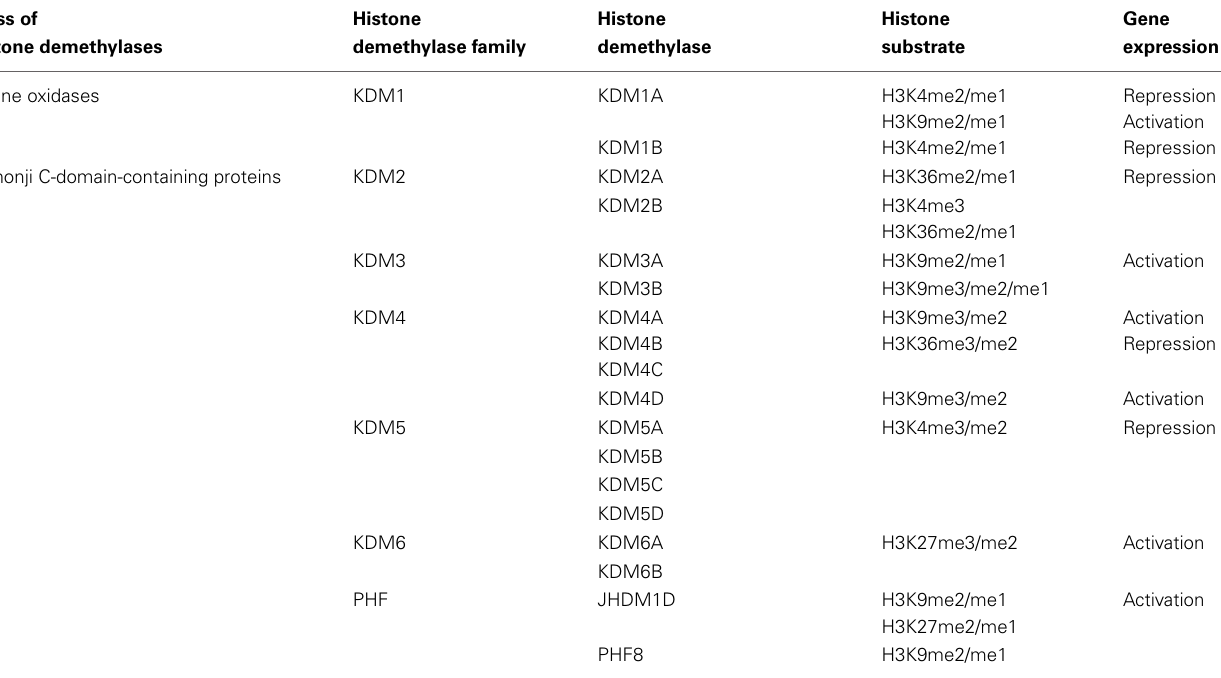
Table 1 | A simplified list of the members of the two classes of histone demethylases (mentioned in the